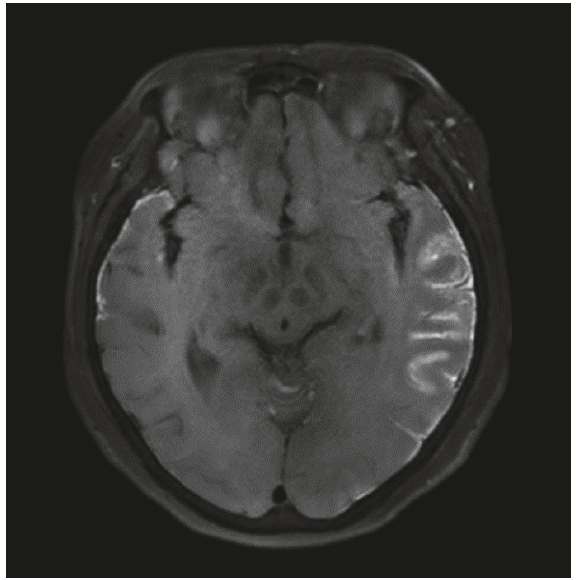
Figure 2: Cranial-enhanced MRI T1-weighted images reveal abnor- mal linear hyperintensity mainly on the left lateral